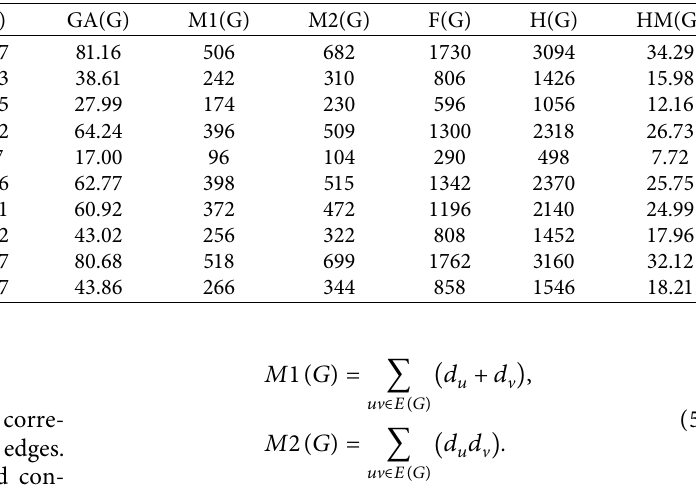
Table 1: The TIs values of candidate